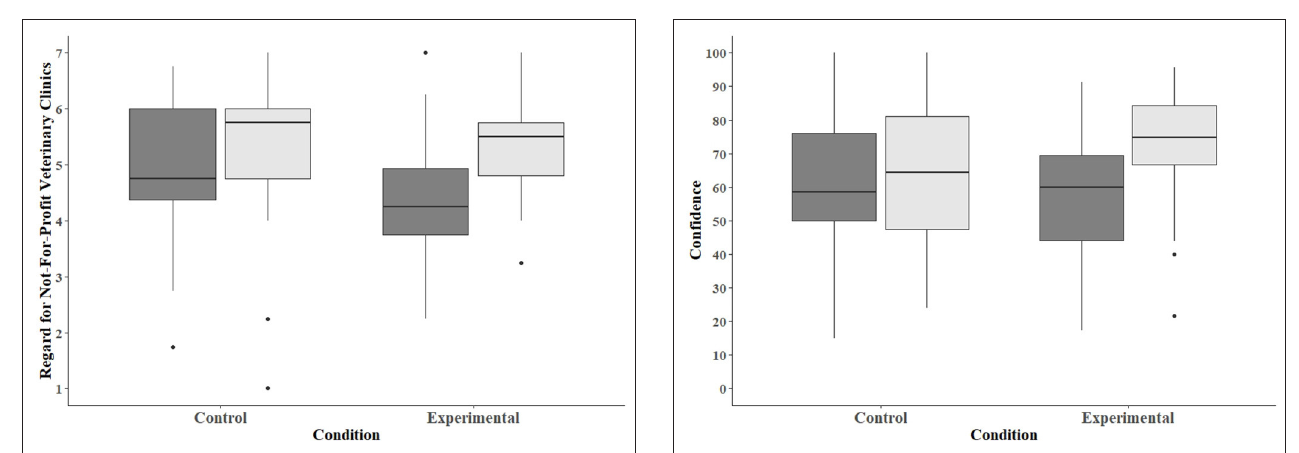
FIGURE 2 | Box plot depicting the scores assessing participants’ regard for not-for-profit veterinary clinics. Dark-gray bars represent scores on the pretest, and light-gray bars scores on the post-test.